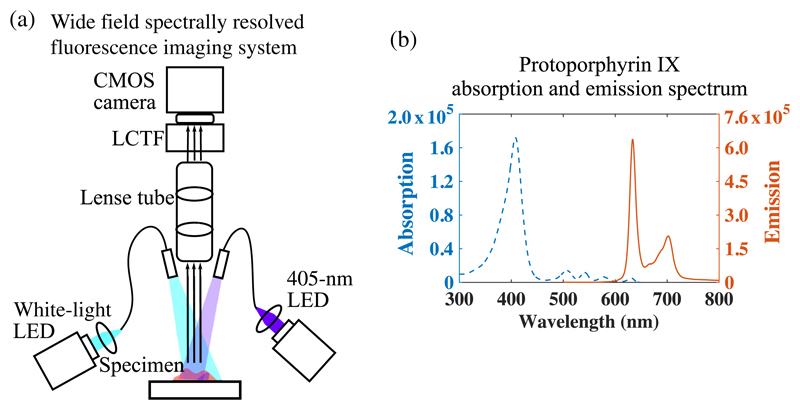
(a) Schematic of system setup and (b) the excitation and emission spectrum of PpIX (A.U.) plotted from published data.25 LCTF, liquid crystal tunable filter and MO, microscope objective.